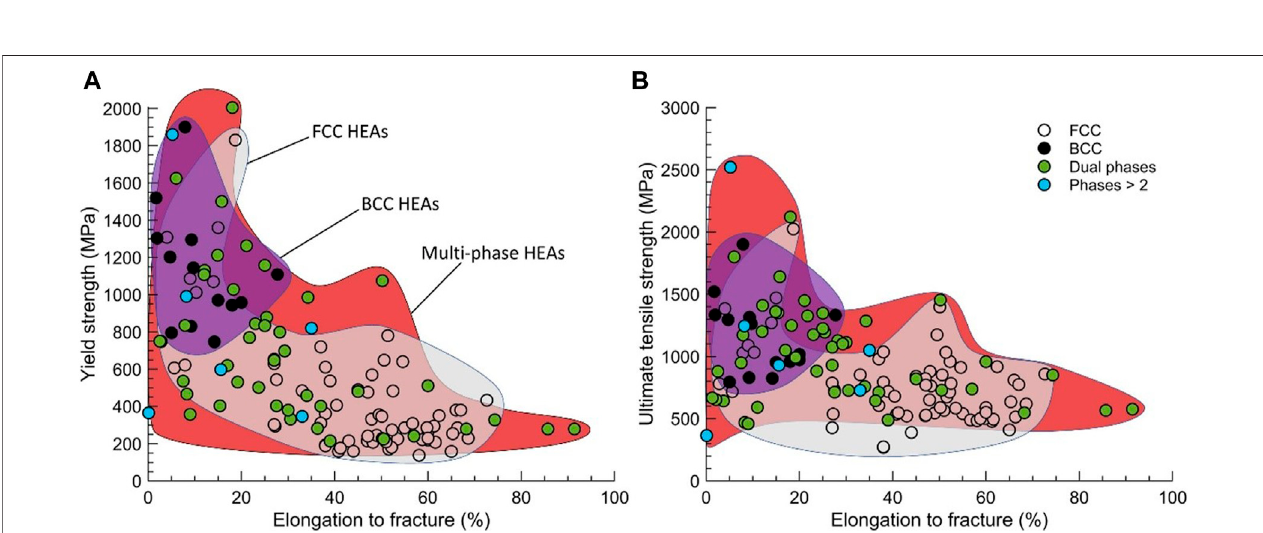
Frontiers in Materials |